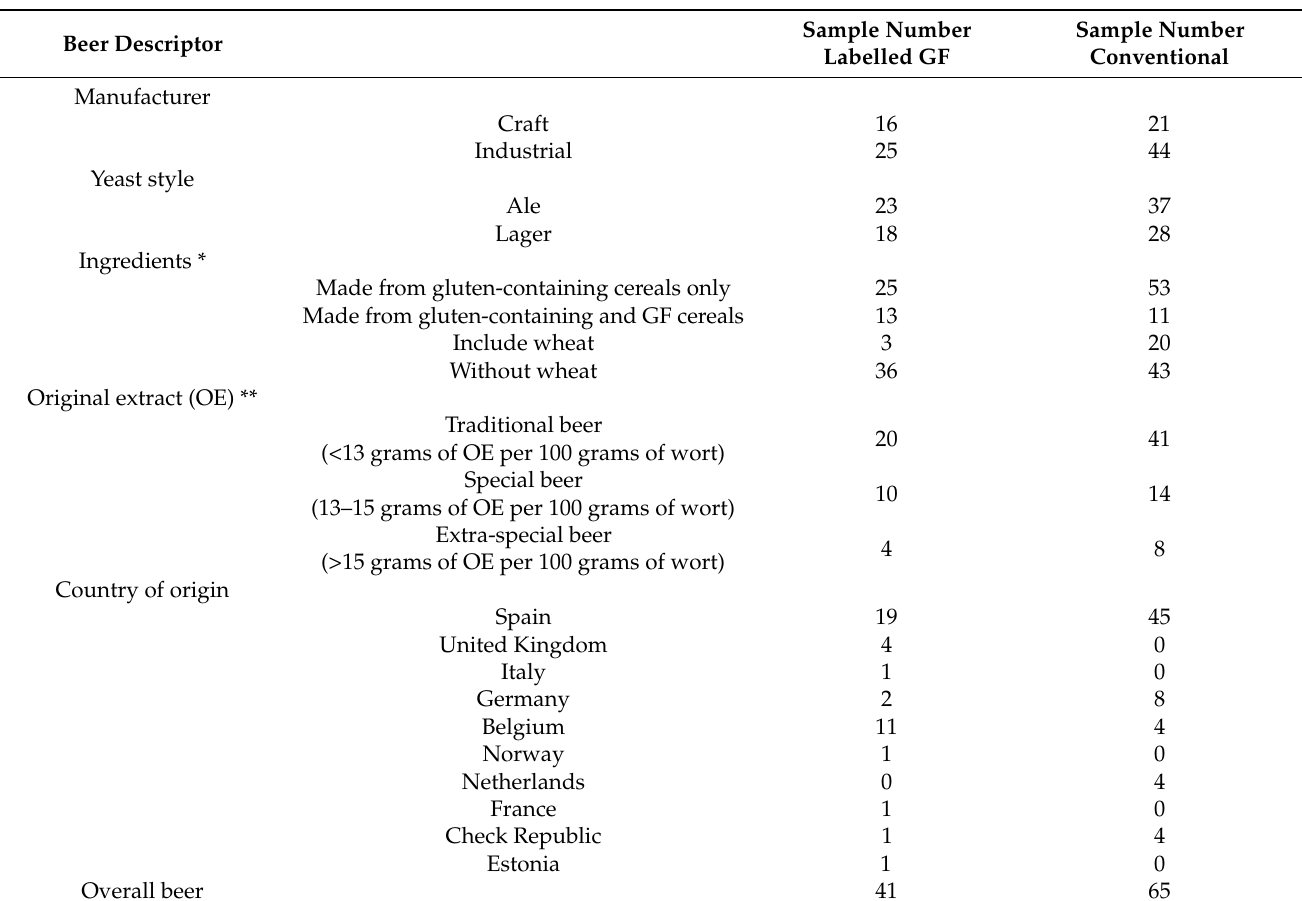
Table 1. Characteristic of beer